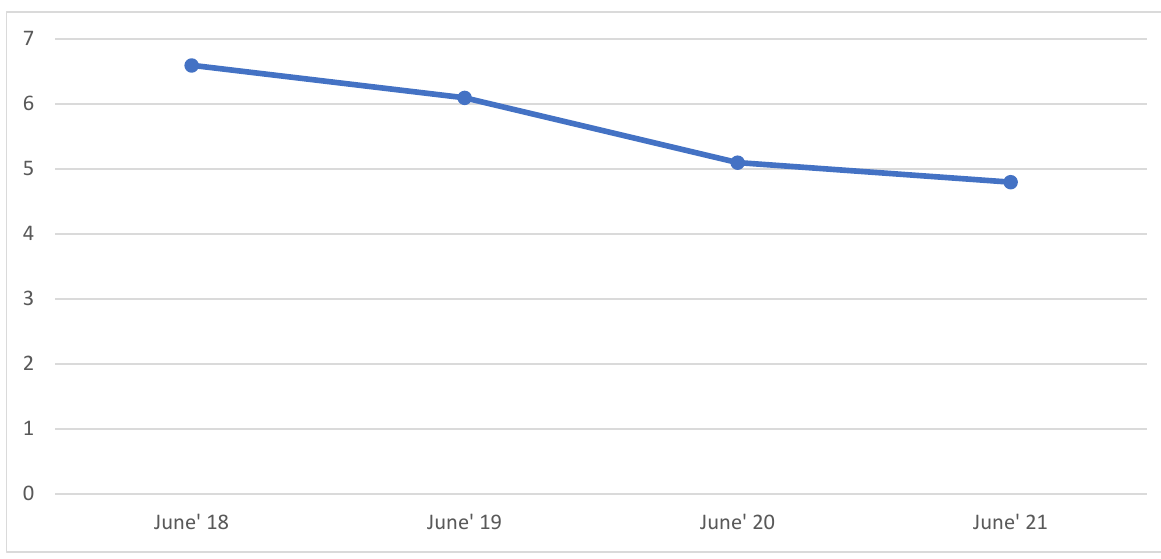
Figure A1. Share of Ijarah in the financing portfolio of Islamic Banks (% share).